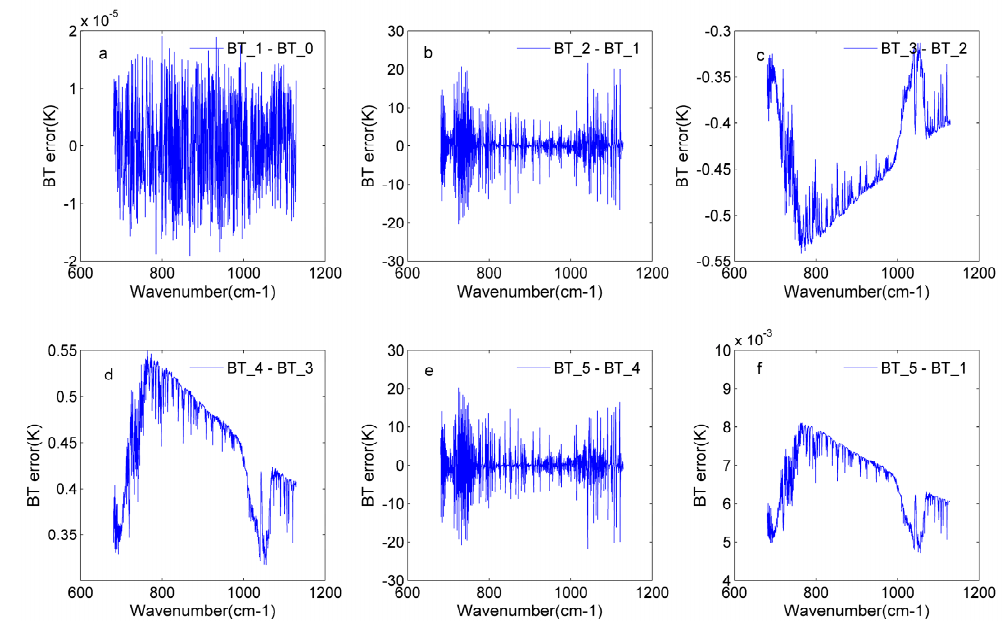
Figure 14. The BT error for detector 81 in the whole simulation process: ( a ) the BT error in the input BT (BT_0) and ideal BT (BT_1); ( b ) the BT error in the BT with off-axis effects (BT_2) and the ideal BT; ( c ) the BT error in the BT with off-axis effects and non-linearity response (BT_3) and BT_2; ( d ) the BT error in the BT after non-linearity correction (BT_4) and BT_3; ( e ) the BT error in the BT after off-axis correction (BT_5) and BT_4; f) the BT error in the BT_5 and BT_1.